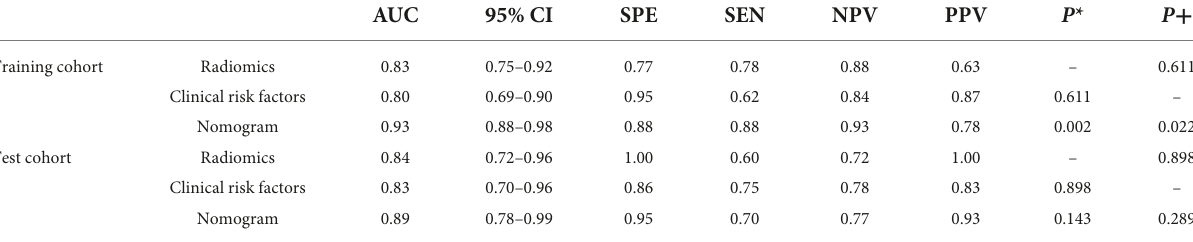
TABLE 2 Diagnostic performance of the training and test cohorts.